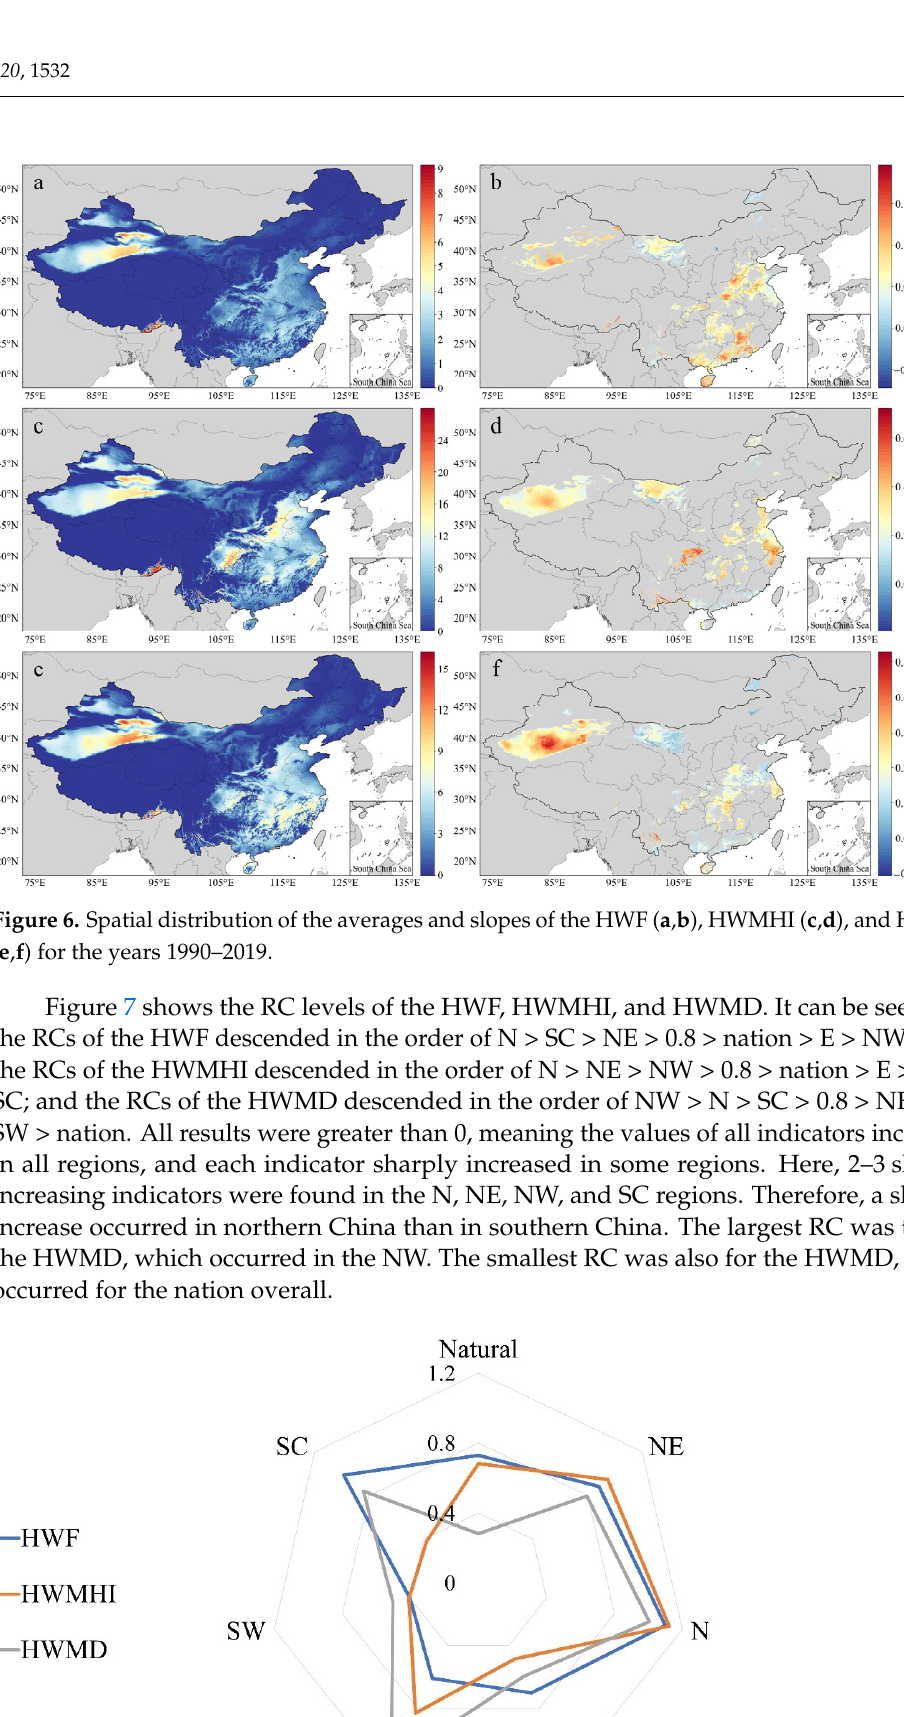
Figure 7. RC values of HWF, HWMHI, and HWMD.